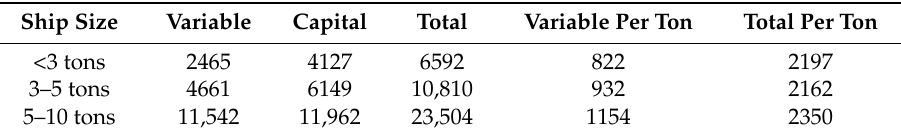
Table 3. Fishing expenditures in Obama by ship tonnage in 2015 (1000